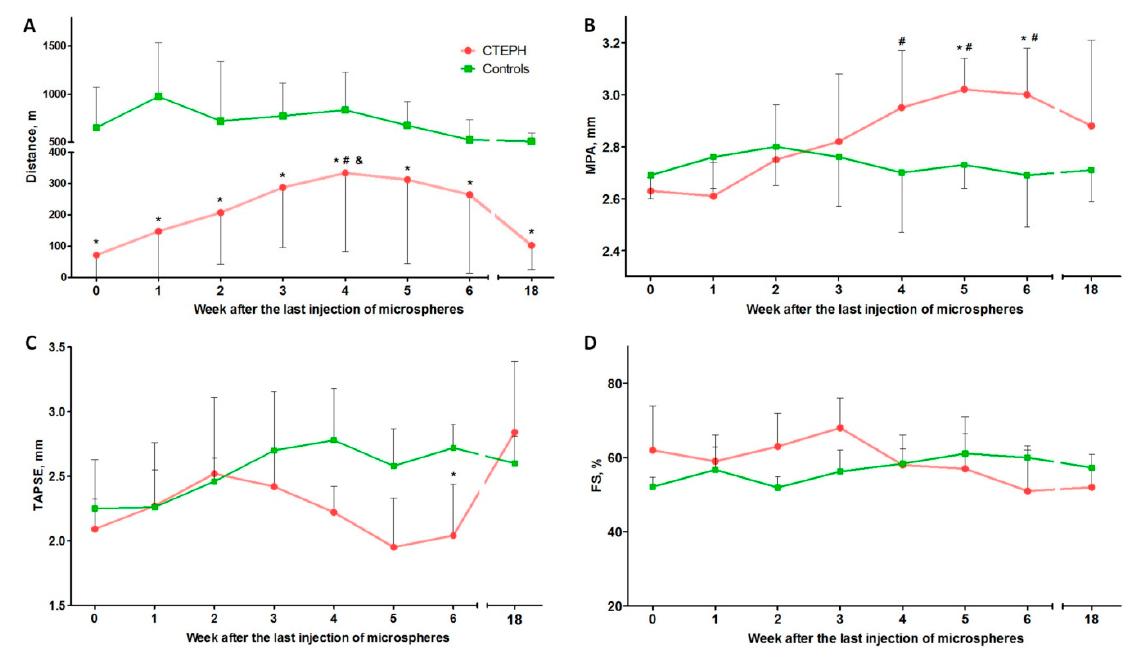
Figure 1. Results of non-invasive tests. ( A ) Assessment of exercise tolerance according to the treadmill test. ( B – D ) Results of echocardiographic examination. ( B ) The diameter of the main pulmonary artery (MPA). ( C ) Systolic excursion of the tricuspid annulus plane. ( D ) Left ventricle (LV) shortening fraction. * p < 0.05 in comparison with the control group. # p < 0.05 in comparison with the 0-week subgroup. & p < 0.05 in comparison with the 18-week subgroup. n = 7 at each time point in the chronic thromboembolic pulmonary hypertension (CTEPH) group.